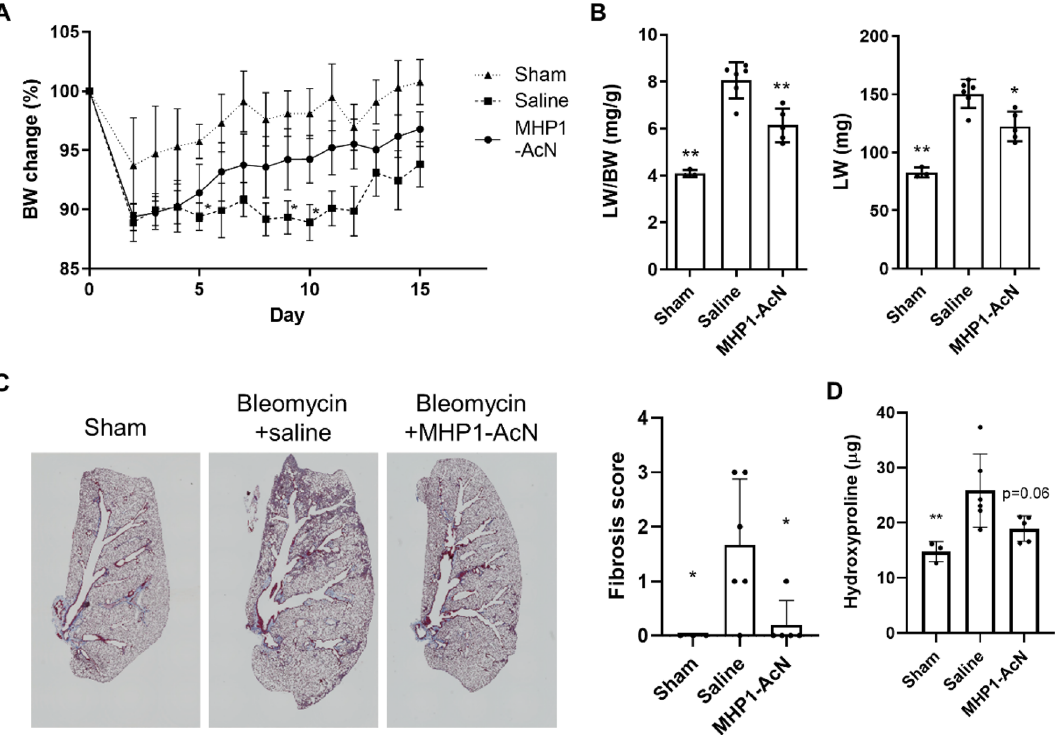
Figure 1. MHP1-AcN prevented the progression of bleomycin-induced lung fibrosis. ( A ) Change of body weight after intrathecal administration of bleomycin. MHP1-AcN (800 µg/day) was started immediately before intrathecal injection and continued for 14 days. Sham-operated mice received saline instead of bleomycin. Recovery of body weight was delayed in saline-treated mice. * p < 0.05 vs sham-operated mice. ( B ) Lung weight (LW) to body weight (BW) ratio (LW/BW) (left panel) and LW (right panel). MHP1-AcN inhibited increases in LW/BW and LW. * p < 0.05, ** p < 0.01 vs Saline-treated mice. ( C ) Representative images of Masson’s trichrome stain (left panel) and semi-quantification of fibrosis score (right panel). MHP1-AcN inhibited fibrosis. * p < 0.05 vs Saline-treated mice. ( D ) Hydroxyproline content in lungs of mice. ** p < 0.01 vs Saline-treated mice. n = 3